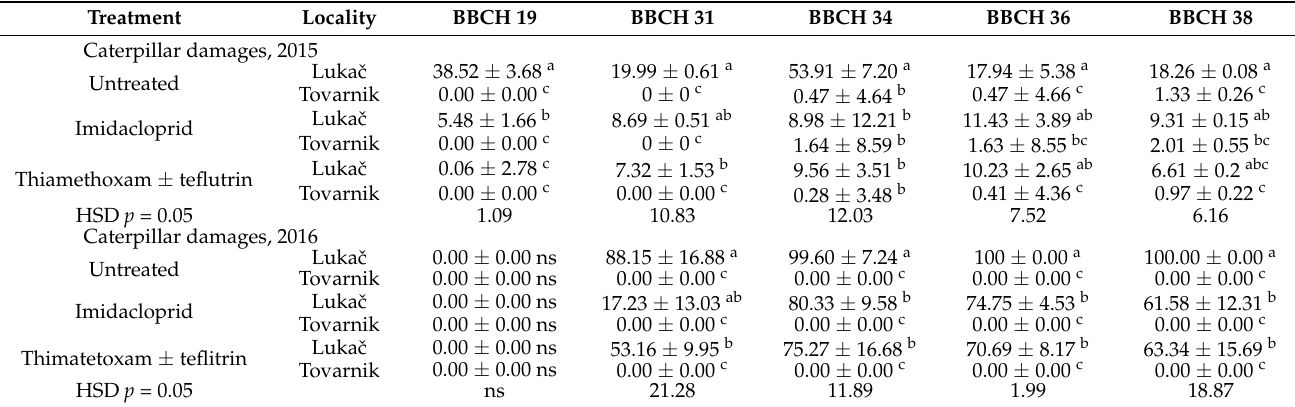
Table 7. Sugar beet plants infected (in %) by caterpillars in different developmental stages (BBCH). Treatment